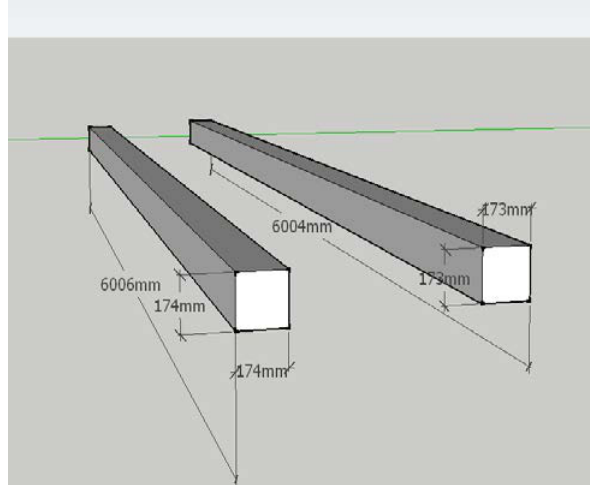
Figure 4. 3D Model Precast Concrete for 175mm x 175mm x